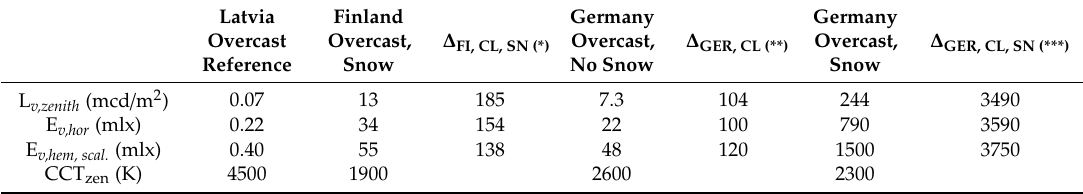
Table 4. Comparing the parameters of the winter overcast nights in Finland and Germany to the commonly used average clear sky night sky brightness of 0.25 mcd / m 2 (ca. 21.6 mags / arcsec 2 ). Finland Overcast, Germany Overcast, Germany Overcast, ∆ ∆ ∆ NAT(*) NAT(*) NAT(*) Snow No Snow Snow L v,zenith (mcd / m 2 ) 13 52 7.3 29 244 980